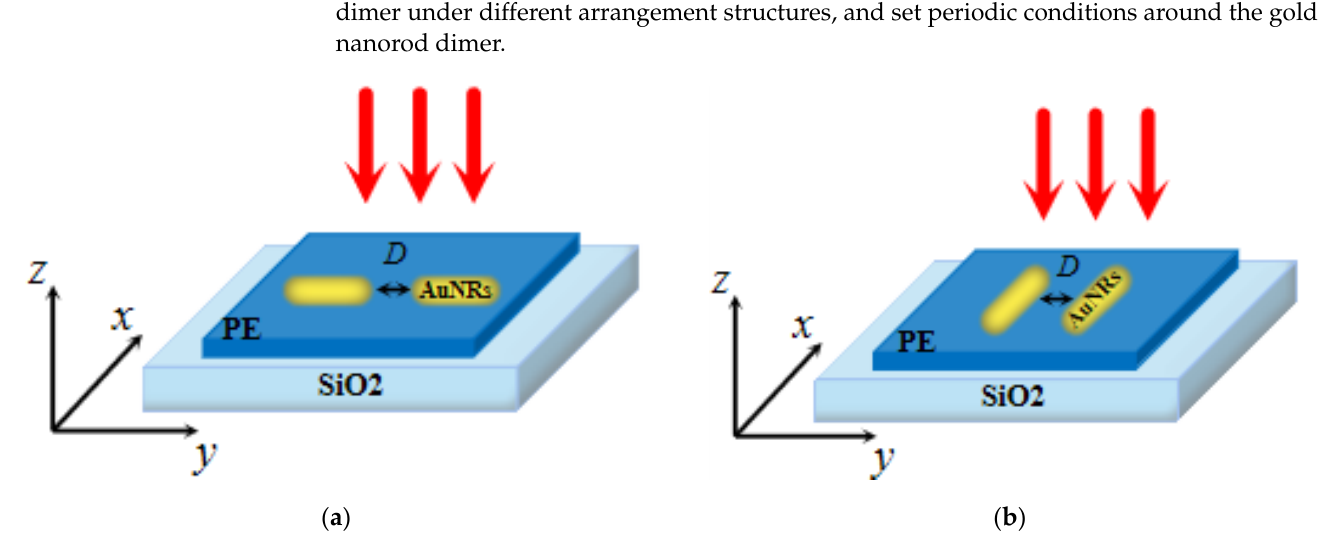
Figure 1. ( a ) Three-dimensional model of the longitudinally aligned gold nanorod dimer-PE-quartz structure; ( b ) three-dimensional model of the juxtaposed gold nanorod dimer-PE-quartz structure. As shown in Figure 1, Au (gold) (Johnson and Christy 1972: n, k 0.188–1.937 µ